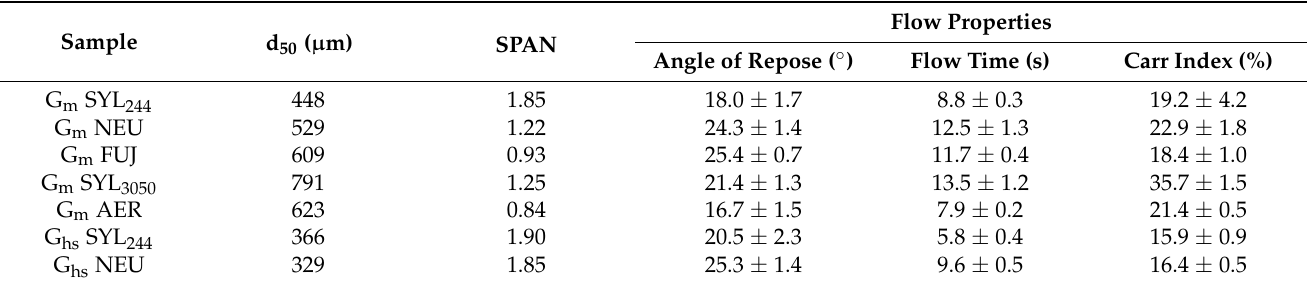
Table 3. Results of SMEDDS granules characterization: size (d 50 ), size distribution (SPAN) and flow properties (angle of repose, flow time and Carr